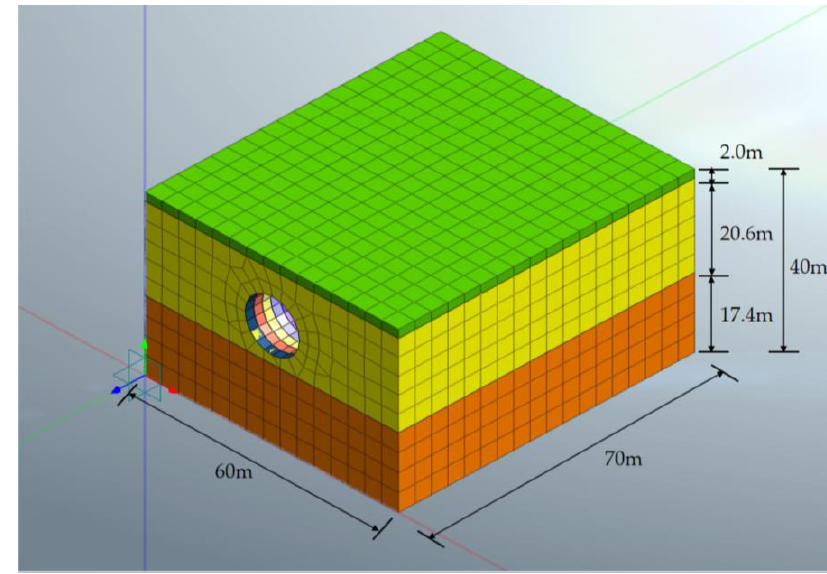
Figure 3. Schematic diagram of the model.